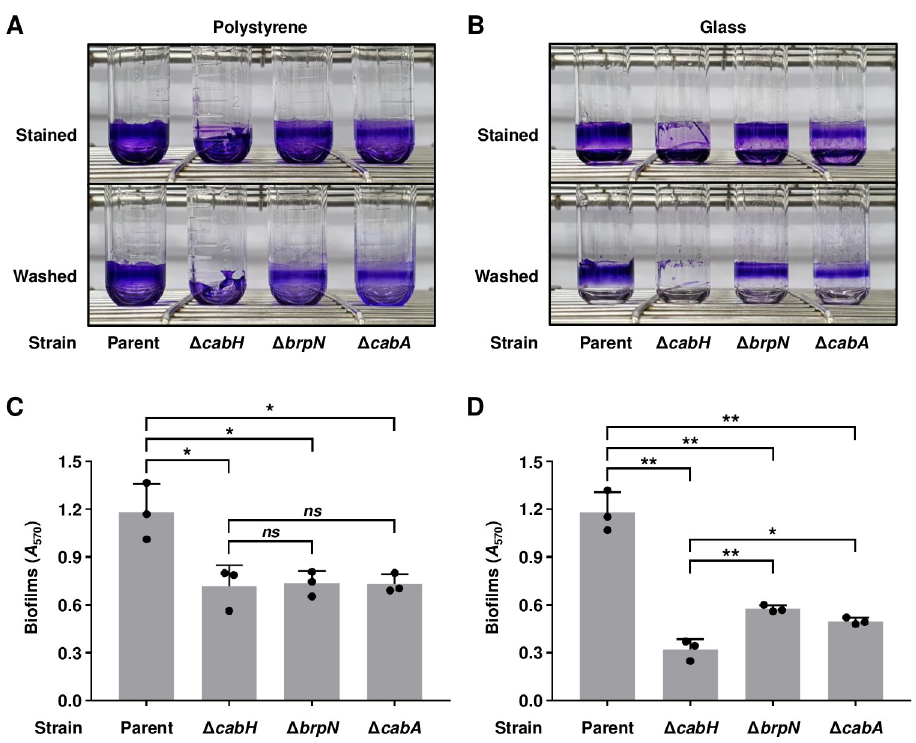
Fig 8. Surface attachment and biofilm formation of the cabH , brpN , and cabA mutants. (A, B) Biofilms of the V . vulnificus strains were grown in VFMG supplemented with 0.01% arabinose in polystyrene (A) or glass (B) test tubes for 24 h. Then supernatants were removed from the tubes and the remaining biofilms were stained with 1% crystal violet. The stained biofilms were then washed with vibration in PBS to remove loosely attached cells. To evaluate the attachment to the test tube surface, each test tube representing the mean result from at least three independent experiments was photographed using a mobile camera. Stained, photographed after the removal of the crystal violet solution; Washed, photographed after being washed with PBS. (C, D) After being washed with PBS, biofilms in the polystyrene (C) or glass (D) test tubes were quantified by eluting the crystal violet and measuring its A 570 ( n = 3). Error bars represent the SD. Statistical significance was determined by the Student’s t test ( � , P < 0.05; �� , P < 0.005; ns , not significant). Parent, parent strain; Δ cabH , cabH mutant; Δ brpN , brpN mutant; Δ cabA , cabA mutant.